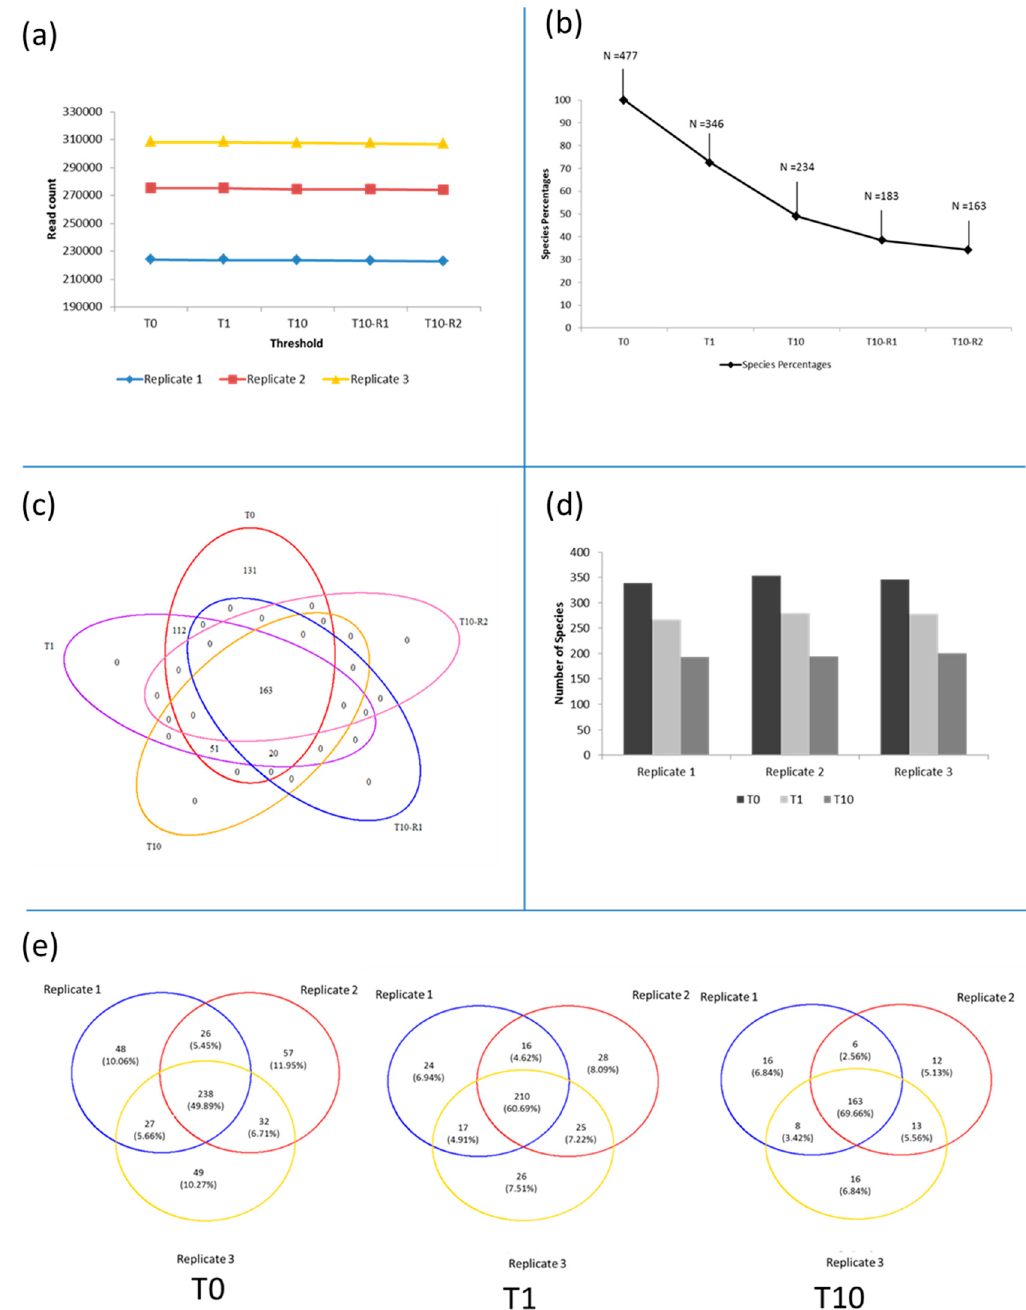
Figure 3. Analyses of the eukaryotic fraction. ( a ) Reduction in number of reads when filters are applied; ( b ) percentage and phylotype count when filters are applied; ( c ) presence–absence analyses at phylotype level before and after application of the filter; ( d ) number of phylotypes analyses by replicate; ( e ) presence–absence analyses at phylotype level when filters are applied to each replicate.